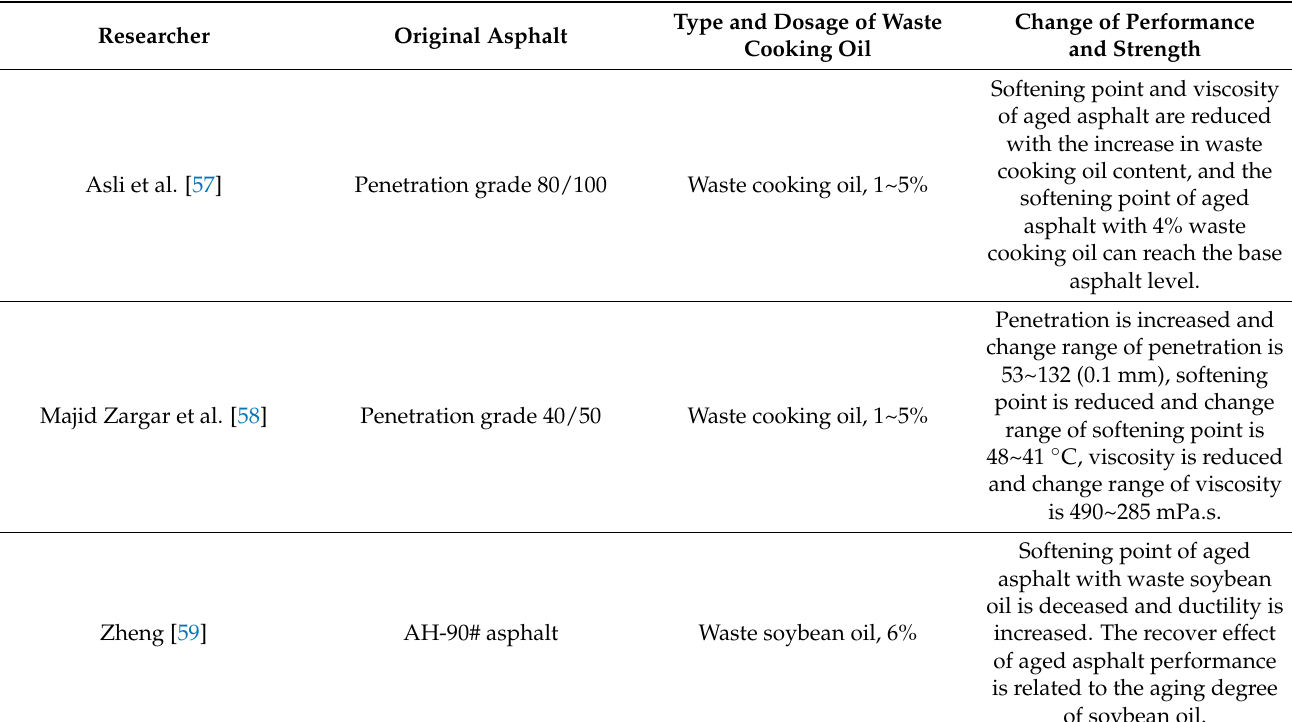
Table 11. Influence of waste cooking oil on performance of aged